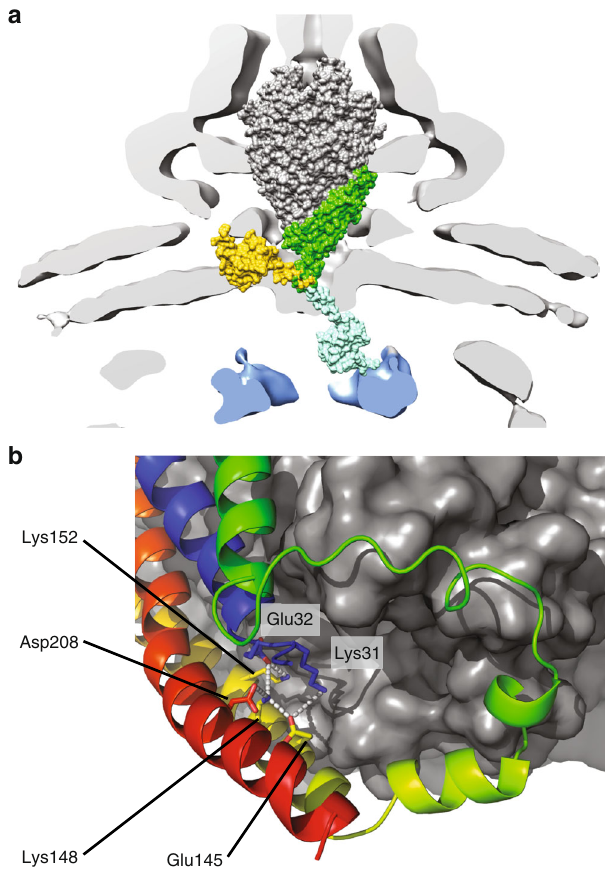
Fig. 5 Position of FlhB C in the complete T3SS. a Placement of FliPQR – FlhB in a tomographic reconstruction of the Salmonella SPI-1 vT3SS (EMD-8544) 47 . FliPQR is shown in grey, FlhB TM in green, two possible positions of FlhB C (PDB: 3b0z) 15 in yellow and light blue, and the density corresponding to the FlhA homologue is highlighted in blue. b Network of salt bridges formed by conserved charged residues in